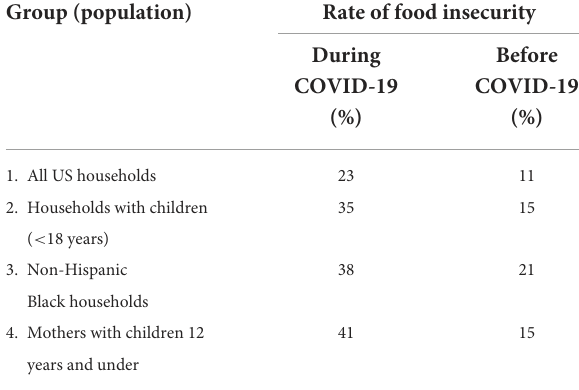
TABLE 2 Rates of food insecurity for specific population groups before and during COVID-19. Group (population) Rate of food insecurity